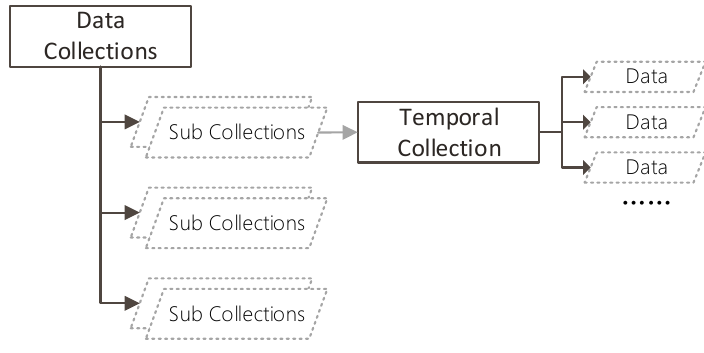
Figure 4. Data-archiving model.